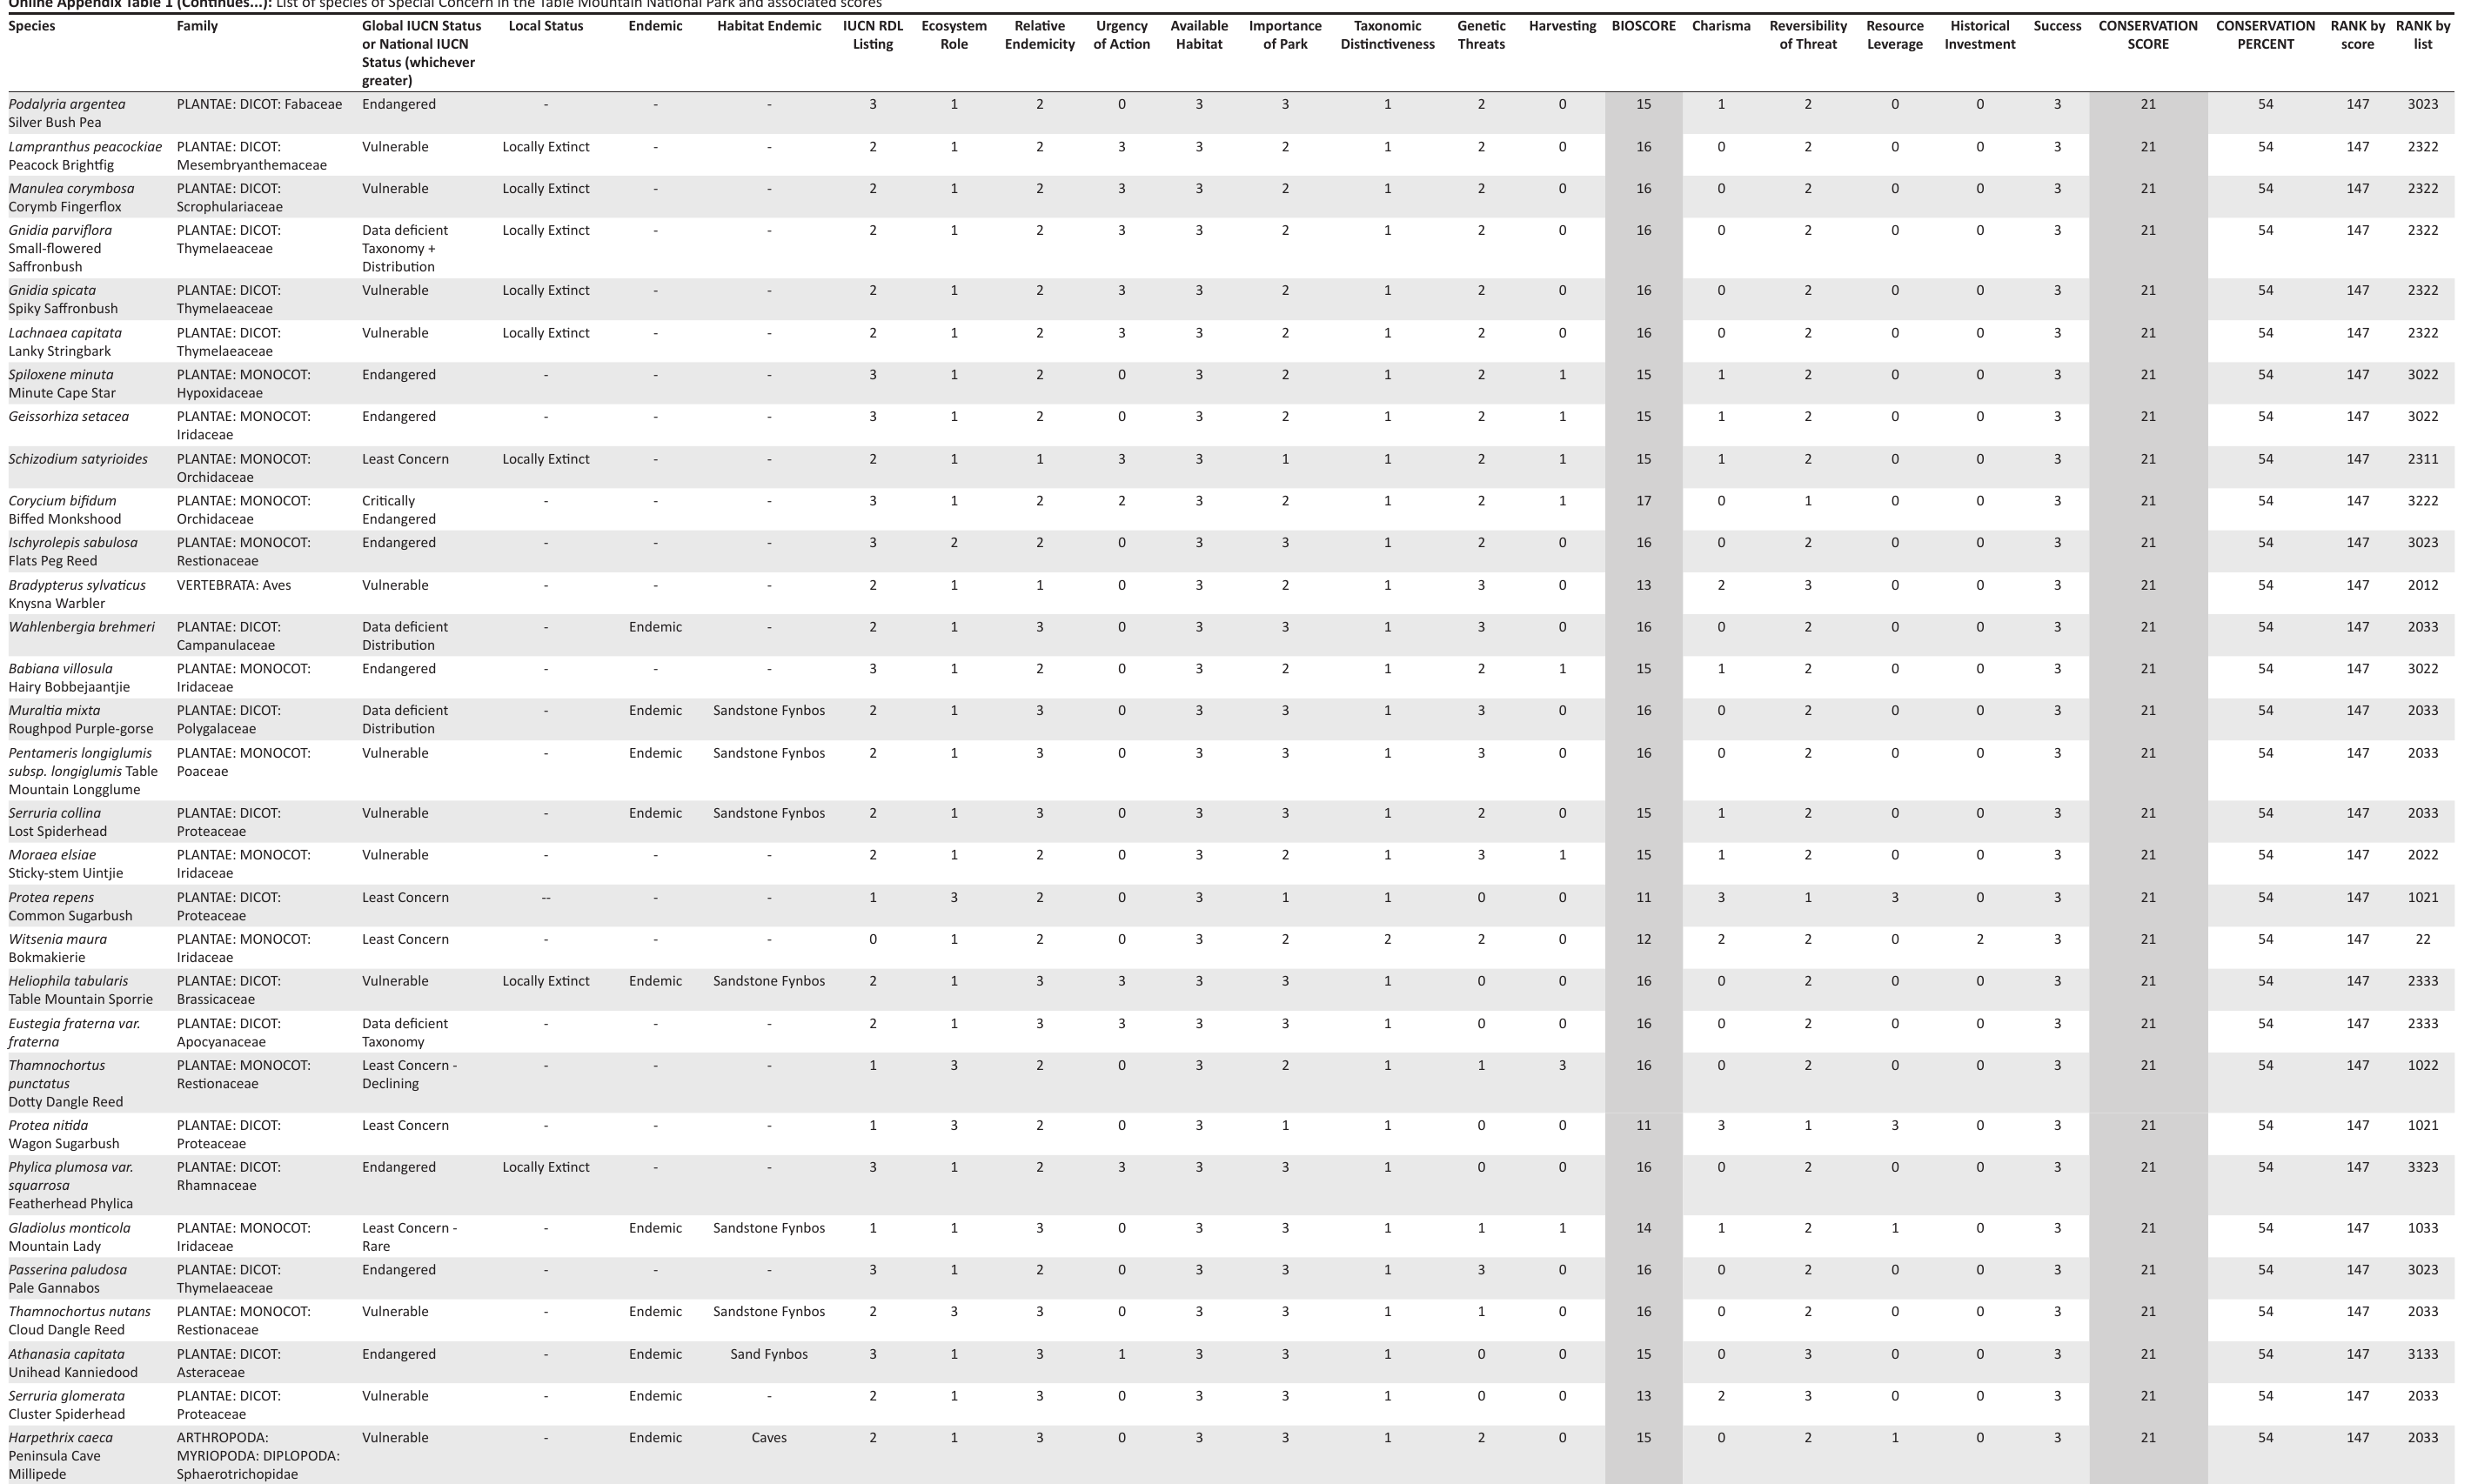
Online Appendix Table 1 (Continues...): List of species of Special Concern in the Table Mountain National Park and associated